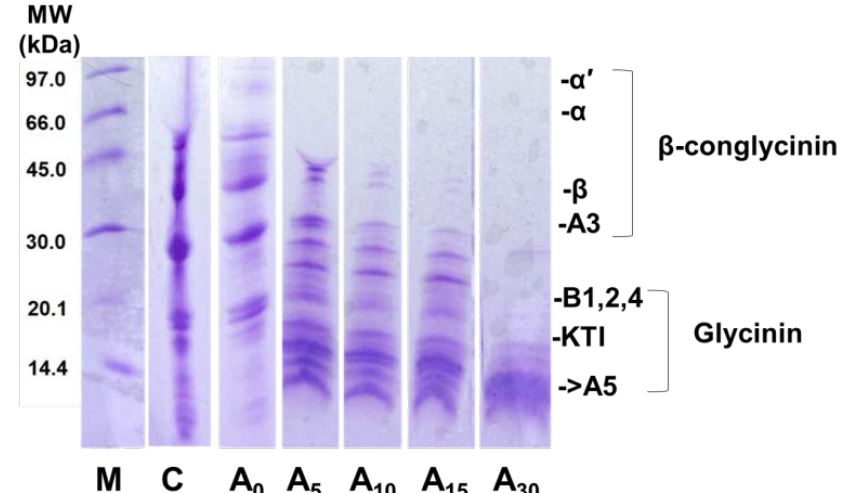
Figure 2. SDS-PAGE profiles of native FBPC protein (C), and FBPC protein hydrolysates viz., slurry with adjusted pH and temperature treatment without Alcalase (A 0 ), 5 min hydrolysis with Alcalase (A 5 ), 10 min hydrolysis with Alcalase (A 10 ), 15 min hydrolysis with Alcalase (A 15 ), and 30 min hydrolysis with Alcalase (A 30 ). (M) molecular weight markers .